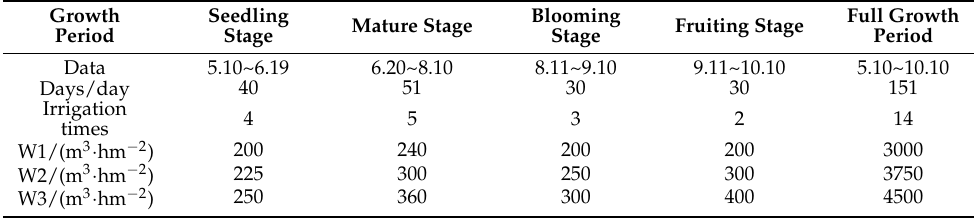
Figure 5. Planting schematics of drip-irrigated Suaeda salsa . Table 11. Suaeda salsa growth period and irrigation